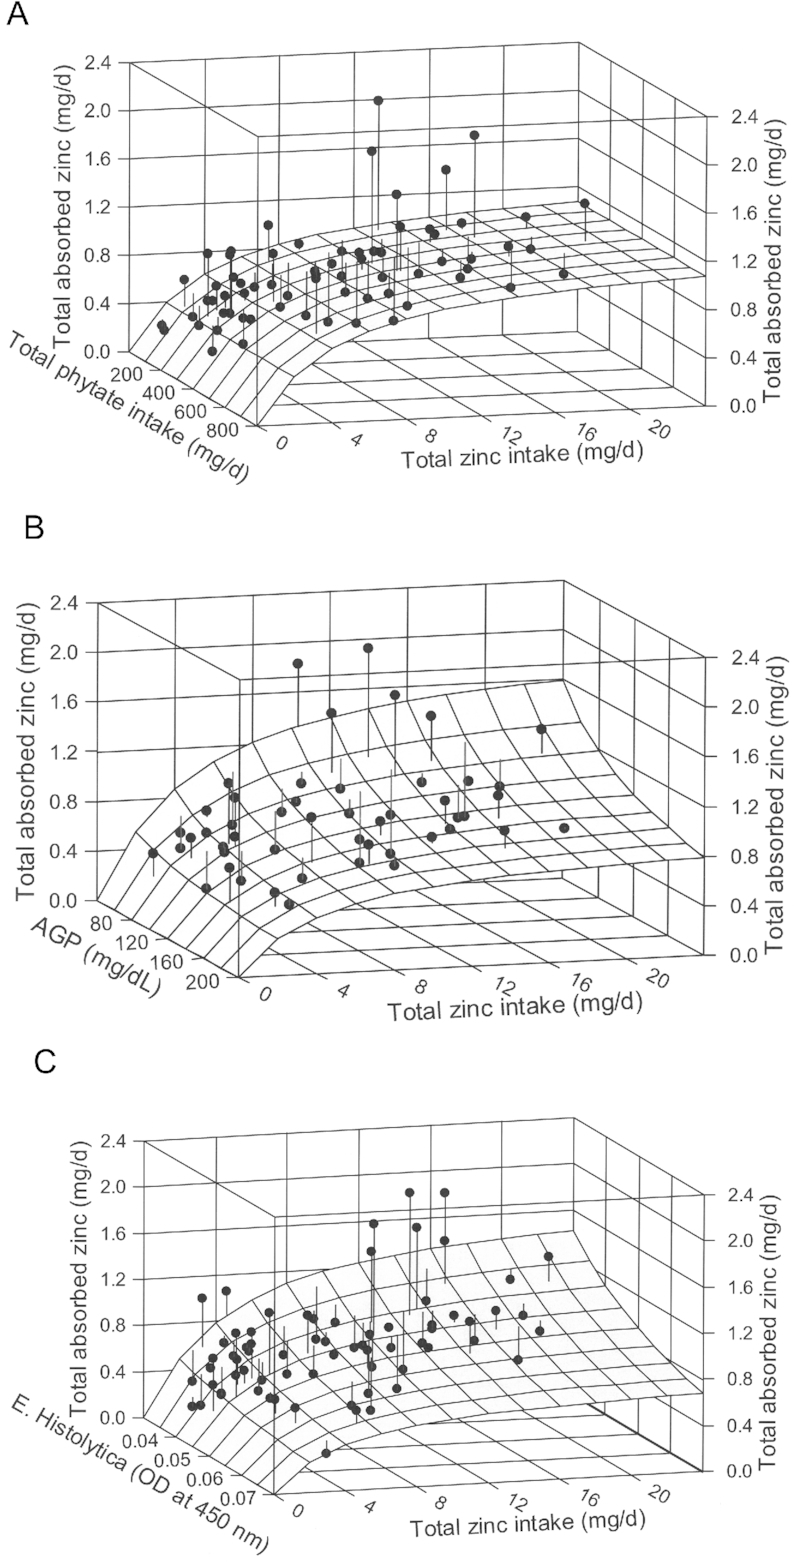
Relations of absorbed zinc to dietary zinc and (A) phytate intake, (B) AGP, and (C) E. histolytica in Bangladeshi toddlers. (A) The relation of total absorbed zinc to total dietary zinc and dietary phytate intakes for the combined L:M groups. The surface shows the fit of a saturation response model (38) to the data. The absence of a phytate effect on absorption is apparent from the lack of a slope in the phytate axis. The vertical lines from data symbols to the model surface represent the deviations between data and the model. The parameter data for the models are presented in Table 4. (B) The relation of total absorbed zinc to total dietary zinc intake and serum concentration of AGP, a marker of systemic inflammation, showing decreasing absorption with increasing AGP concentration. (C) The relation of total absorbed zinc to total dietary zinc intake and the presence of E. histolytica, an intestinal parasite, showing decreasing absorption with greater infection. AGP, α-1 acid glycoprotein; E. histolytica, Entamoeba histolitica; L:M, lactulose:mannitol ratio.